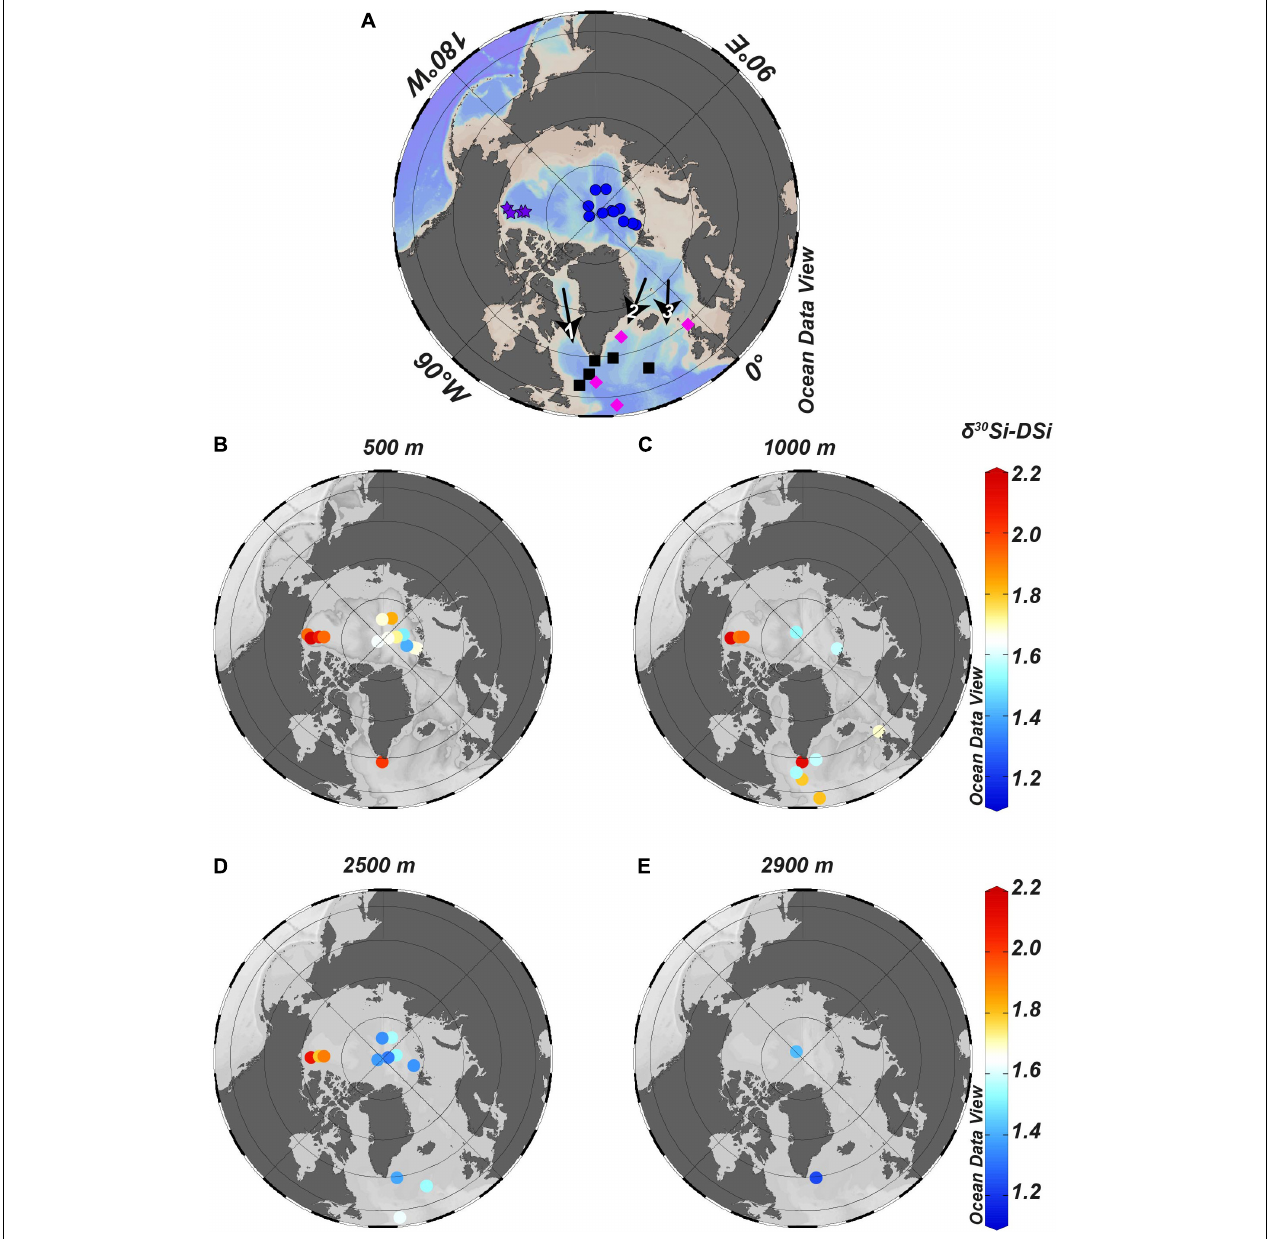
FIGURE 5 | Isosurface plots for δ 30 Si-DSi for different water depths. (A) Map with blue dots represents the stations of the present study, purple stars represent stations of Varela et al. (2016), pink diamonds represent stations of de Souza et al. (2012) and black squares represent stations of Sutton et al. (2018b). Black arrows mark the outflowing waters: 1 = LSW, 2 = DSOW, and 3 = ISOW. (B) δ 30 Si-DSi at 500 m and (C) δ 30 Si-DSi at 1000 m, where Sutton et al. (2018b) determined ∼ 100% LSW contribution. (D) δ 30 Si-DSi at 2500 m, where Sutton et al. (2018b) determined 68% NEADW (precursor of ISOW) contribution. (E) δ 30 Si-DSi at 2900 m, where Sutton et al. (2018b) determined 85% DSOW